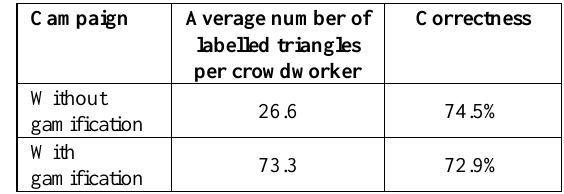
Table 2 . Results of two campaigns without and with